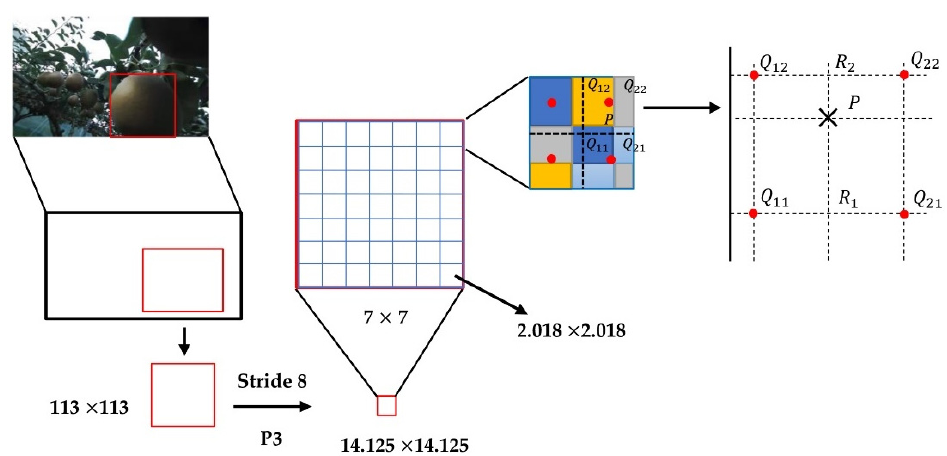
Figure 8. Bilinear interpolation in ROI-Align was used to obtain fixed feature maps for pear recog- nition. P represents pixel coordinates that ROI-Align wanted to obtain after bilinear interpolation. Q 11 , Q 12 , Q 22, and Q 21 represent the four coordinates of known pixel points around point P.